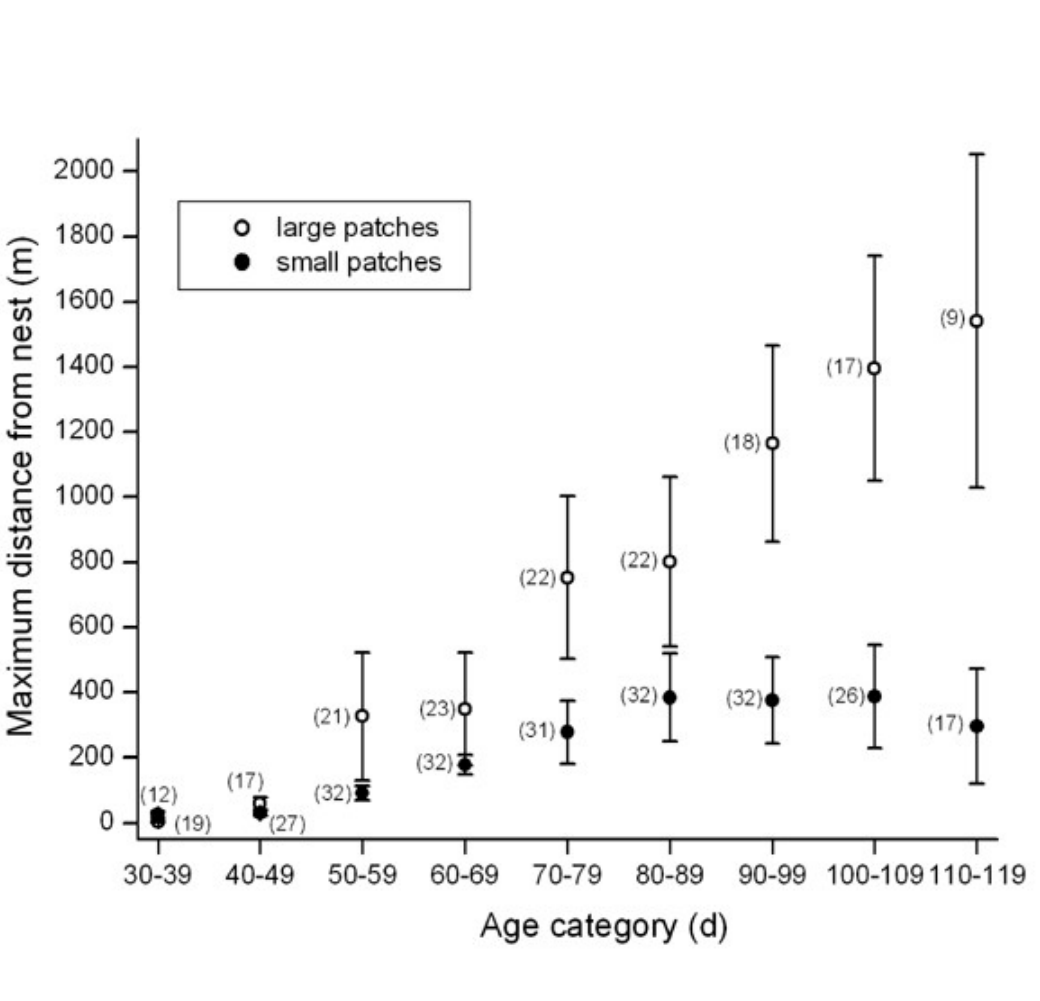
Fig. 1. The maximum distance juvenile Burrowing Owls were found from their nest within 10-d age categories. Means ± SE were derived from repeated measures of 55 individuals (sample sizes in